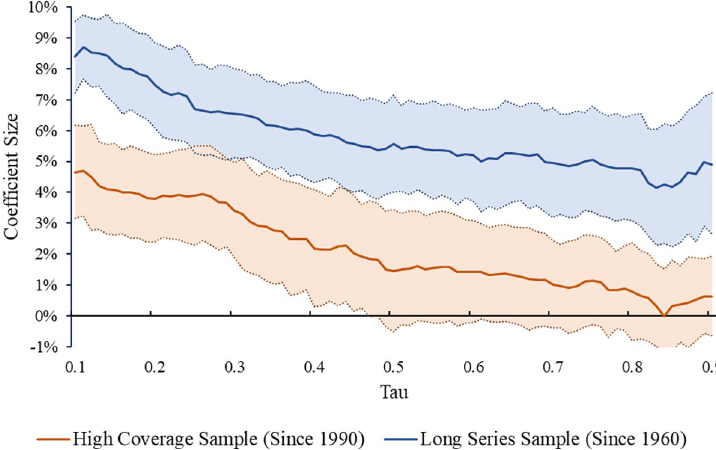
Fig 6. Coefficient of the percent 15 to 29 by homicide rate percentile. Shown is the coefficient of the percent 15 to 29 as a predictor of homicide rate in a quantile regression with fixed effects for each percentile ( τ ) of the distribution of homicide rate. Greater values of τ reflect the effect of percent 15 to 29 on homicide rates conditional on a higher level of homicides. Confidence intervals correspond to an alpha level of 0.95. One series is presented for each the High Coverage and the Long Series